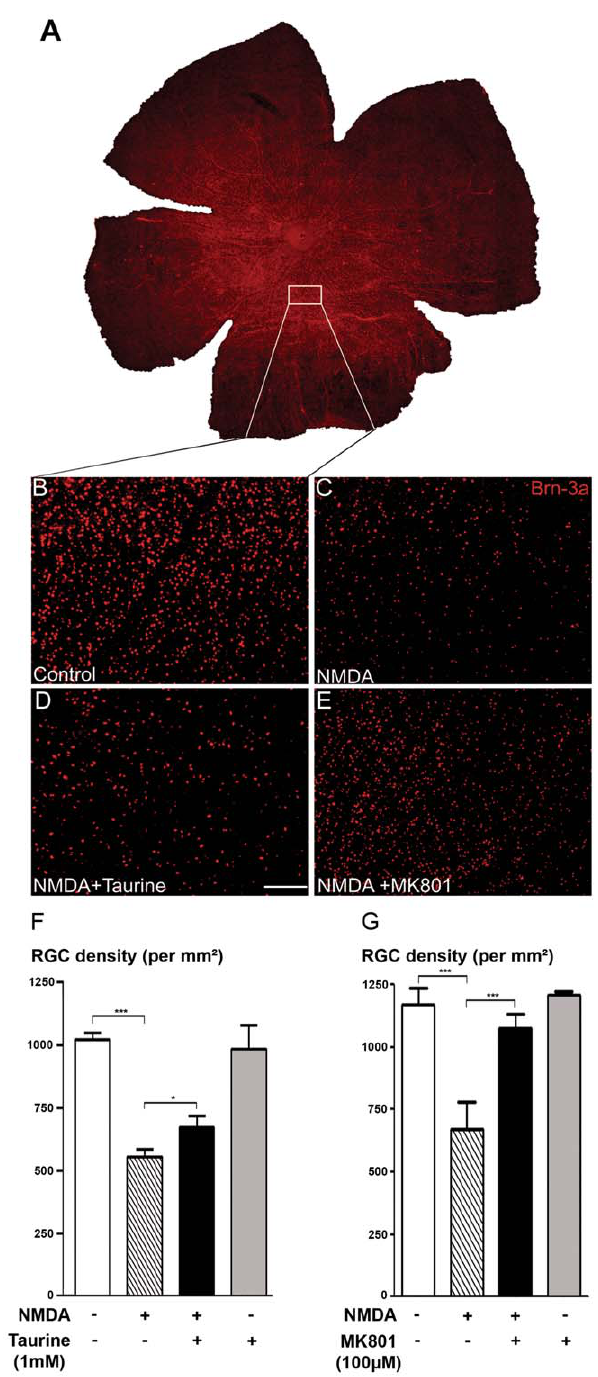
Figure 3. Taurine prevents the RGC death in NMDA-treated retinal explants. A) Digitalized reconstruction of a whole flat- mounted retinal explant immunolabeled with the POU4F1 (Brn3a) antibody. B–E) Representative enlarged fields from flat-mounted retinal explants acquired with the automated platform, showing POU4F1- immunopositive RGCs in a control untreated condition (Control; B) after 100 m M NMDA application (NMDA; C), after co-application of NMDA with taurine (1 mM; NMDA + Taurine; D) or after co-application of NMDA